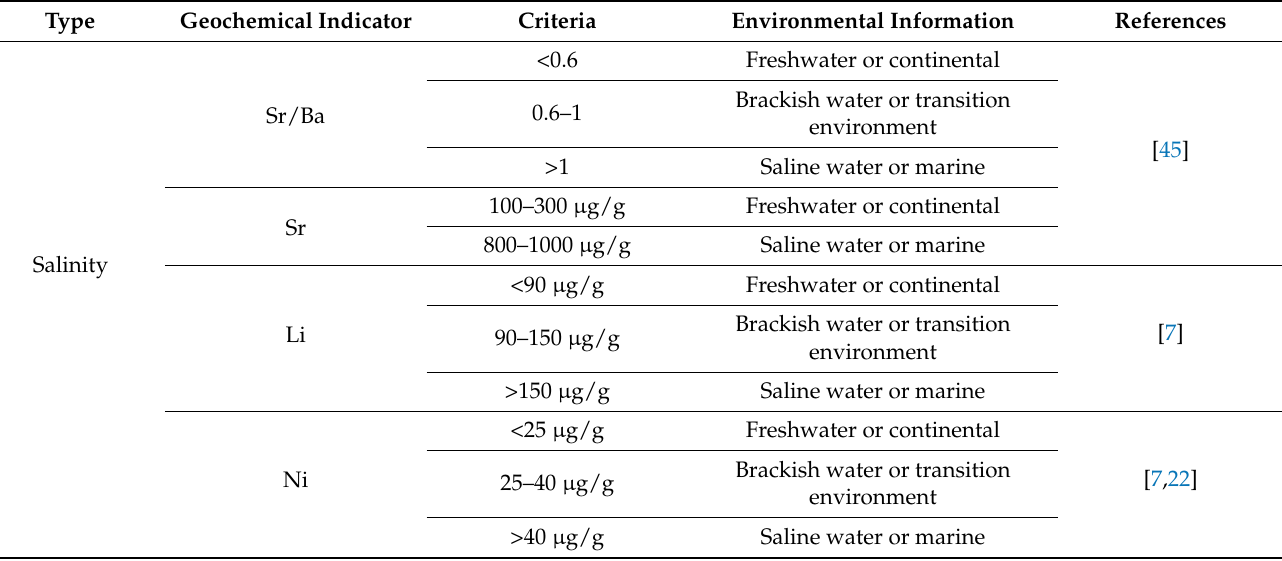
Table 5. Criteria and environmental meanings of geochemical indicators used in the